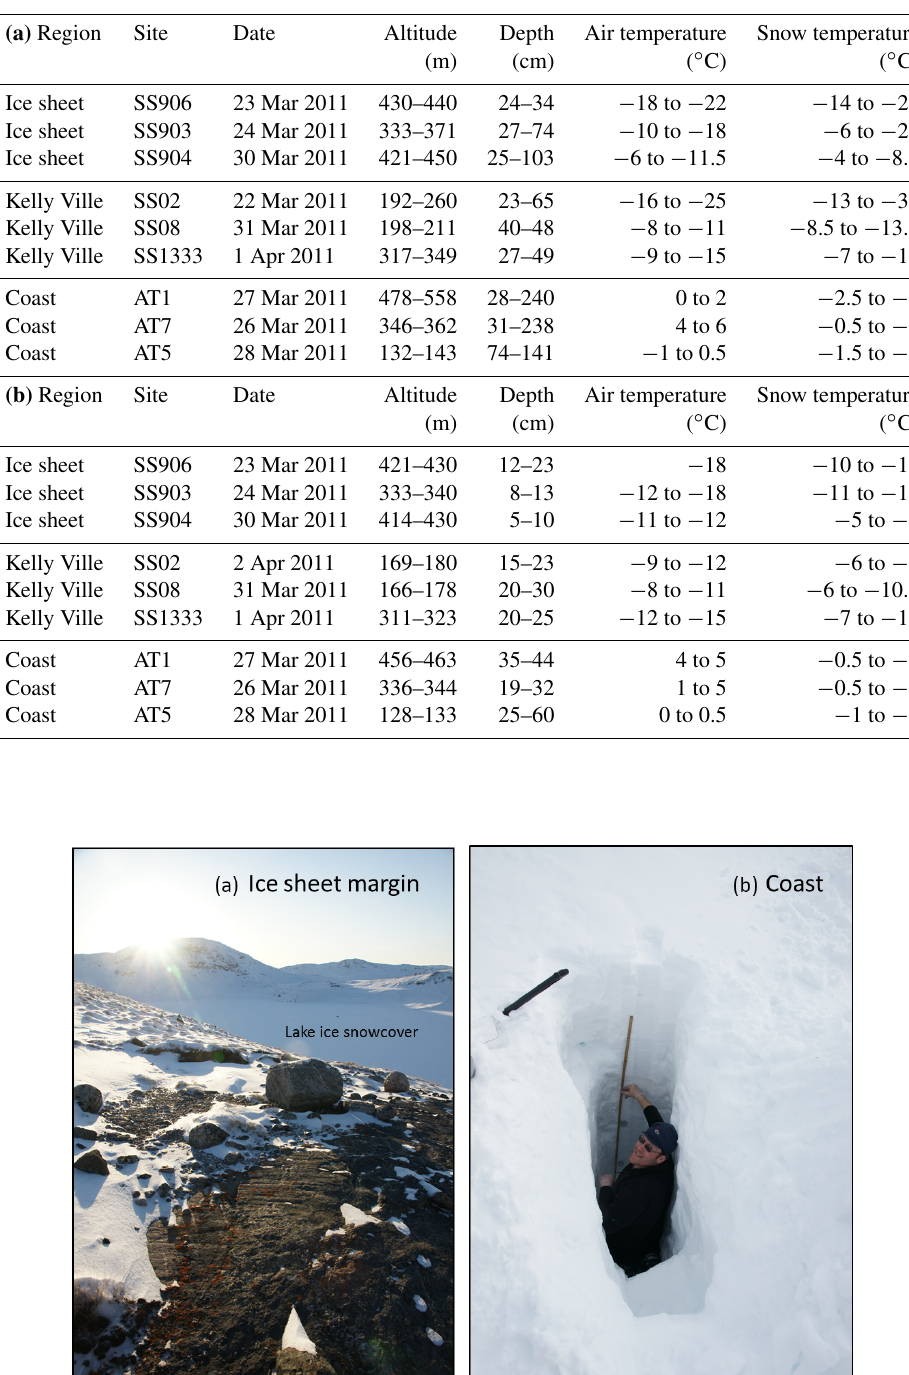
Table 3. (a) Catchment terrestrial snowpack sampling details ( n = 5 per catchment). (b) Lake ice snowpack sampling details ( n = 3 per lake).